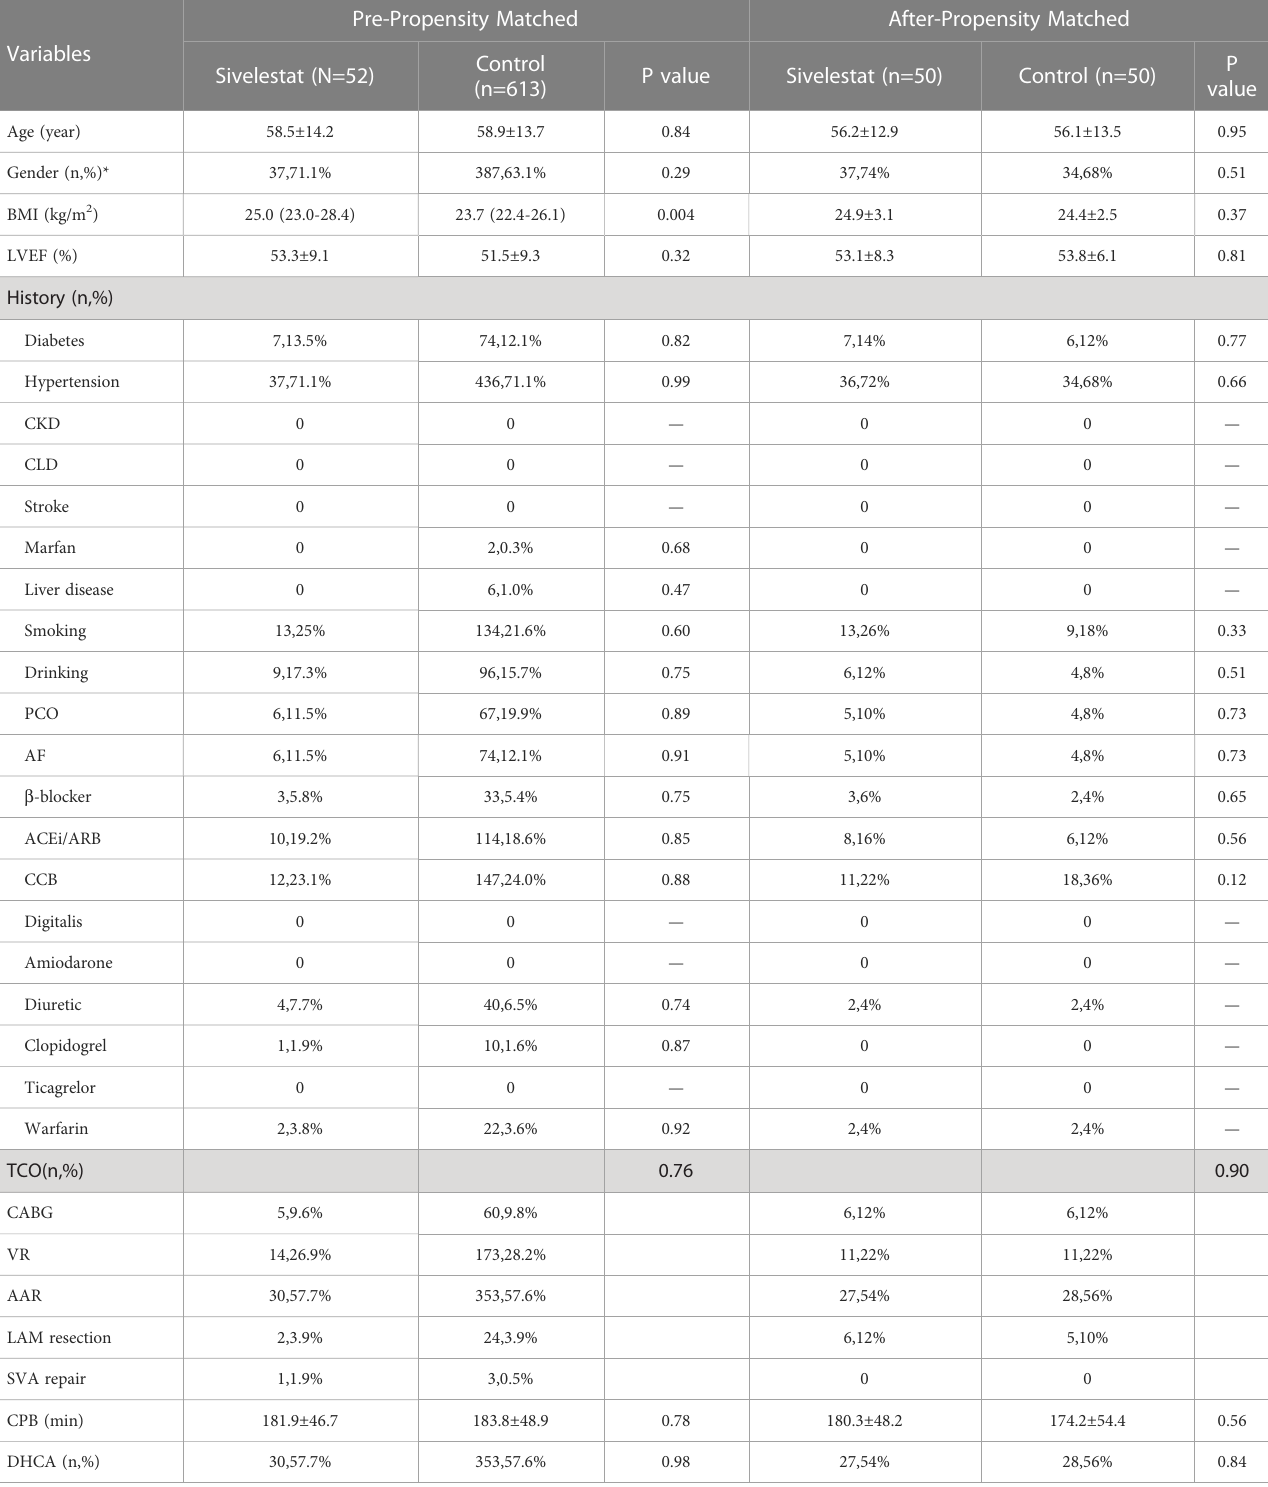
TABLE 2 Characteristics in pre- and after- propensity